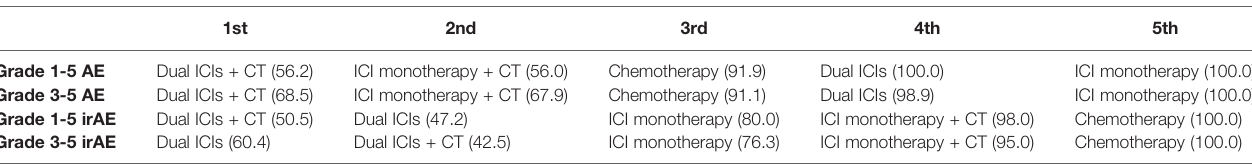
TABLE 2 | Rankings based on overall AE and